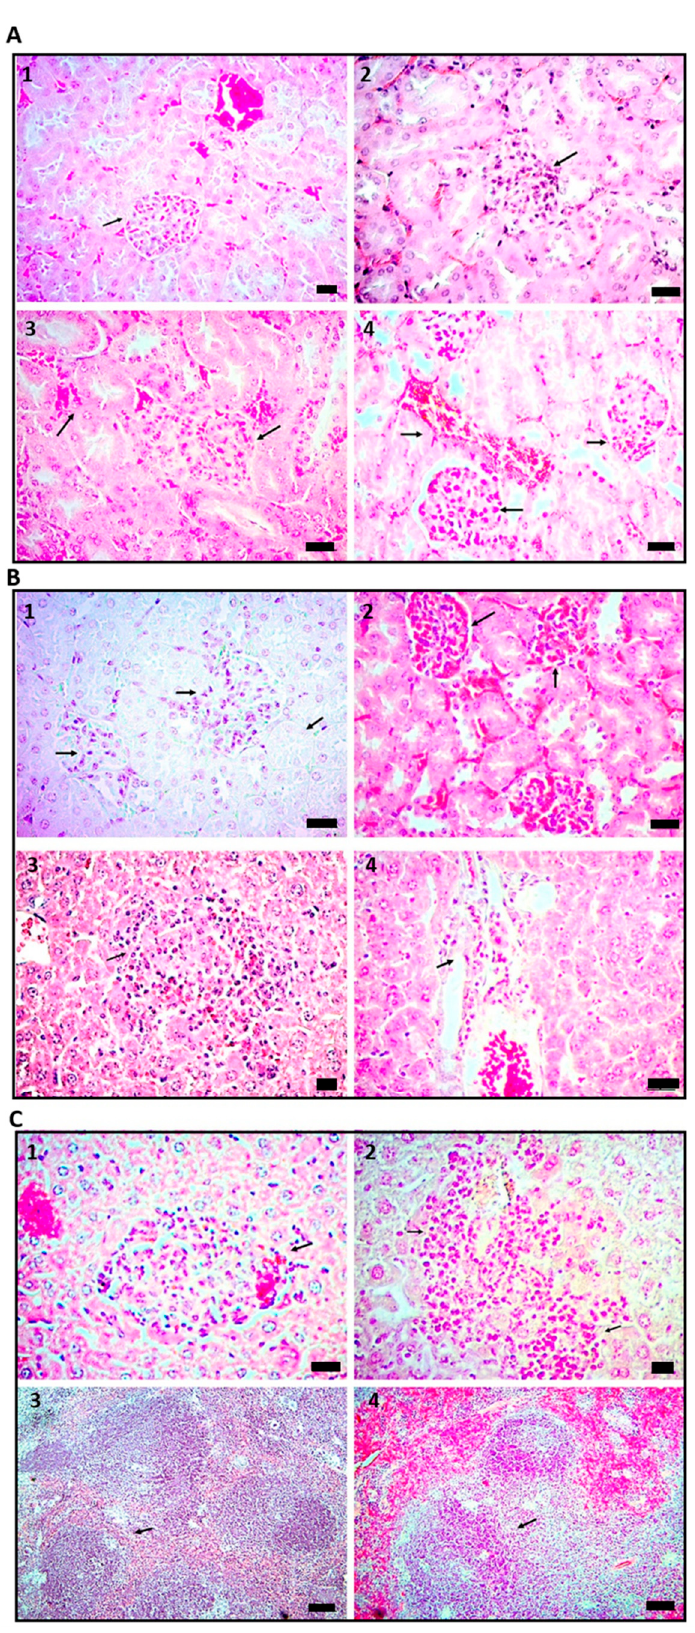
Figure 3. Histopathological features of the kidney, liver, and spleen. ( A1 ) control kidney, arrow point to normal glomerulus; ( A2 ) slight loss of glomerular architecture, vascular congestion, peri-vascular and peritubular inflammatory infiltrate is marked with an arrow, on day 1; ( A3 ) vascular congestion, there was ectasia, focal glomerular hyperplasia with infiltration of polymorphonuclear